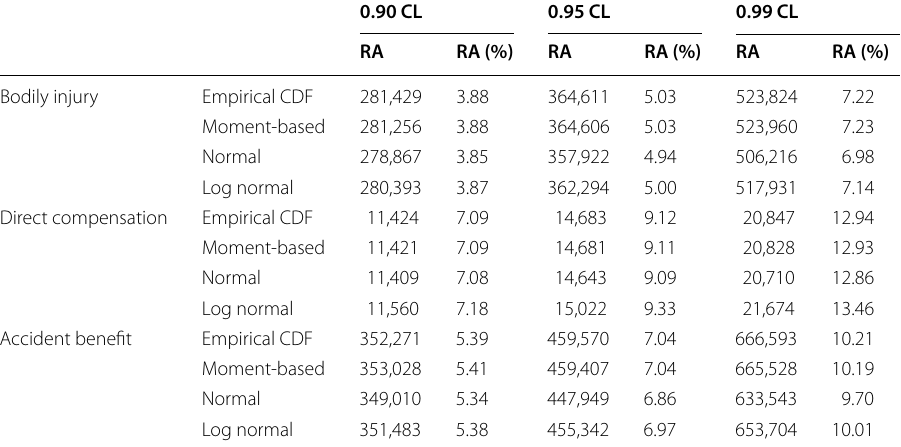
All RA amounts are in thousands in Canadian dollars